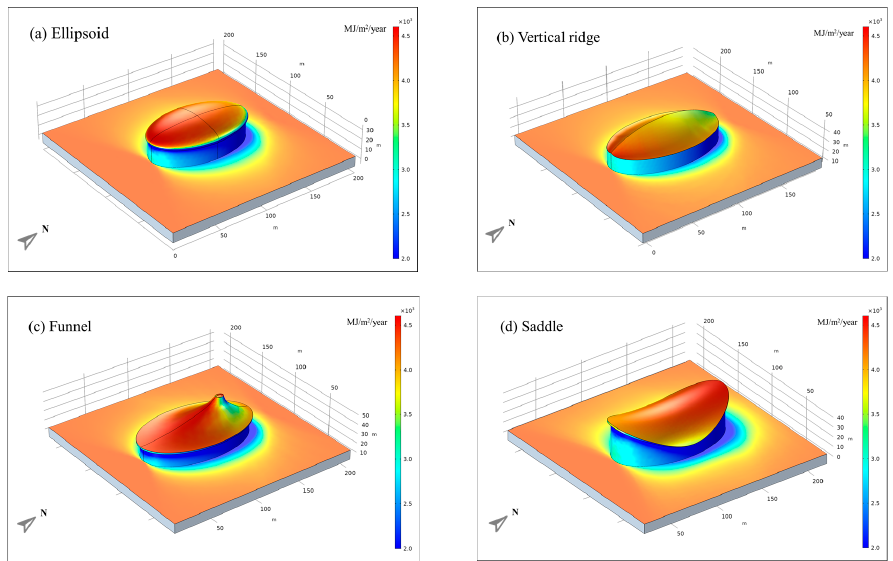
Figure 15. Annual solar radiation intensity of elliptic gymnasium buildings with the various roof shapes. ( a ) Ellipsoid; ( b ) vertical ridge; ( c ) funnel; ( d ) saddle.